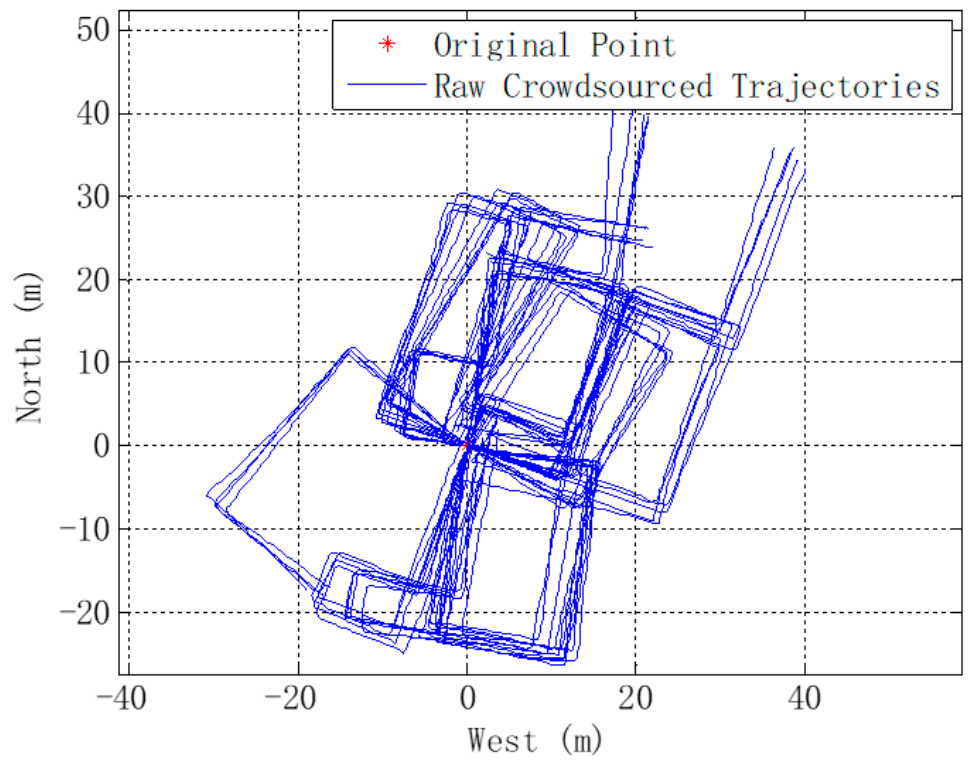
Figure 10. Raw Trajectories by Inertial Odometry.